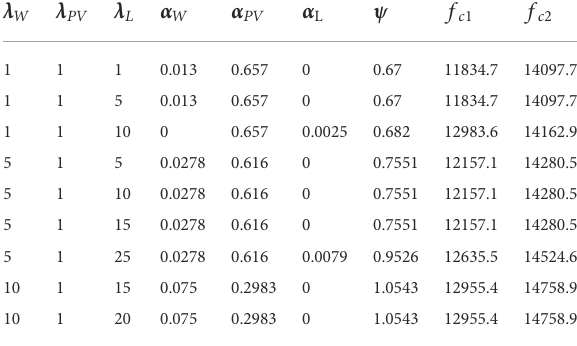
TABLE 3 Uncertainty radius with different types of weight coef fi